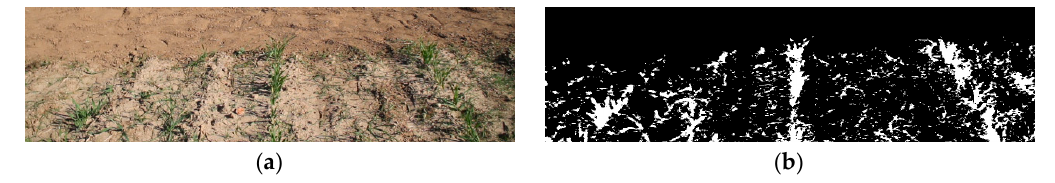
Figure 13. ( a ) Image acquired by the robot of the end of a crop row. ( b ) Segmented image of Figure 13a. The number of pixels that is associated with vegetation (white pixels) is less than 80%